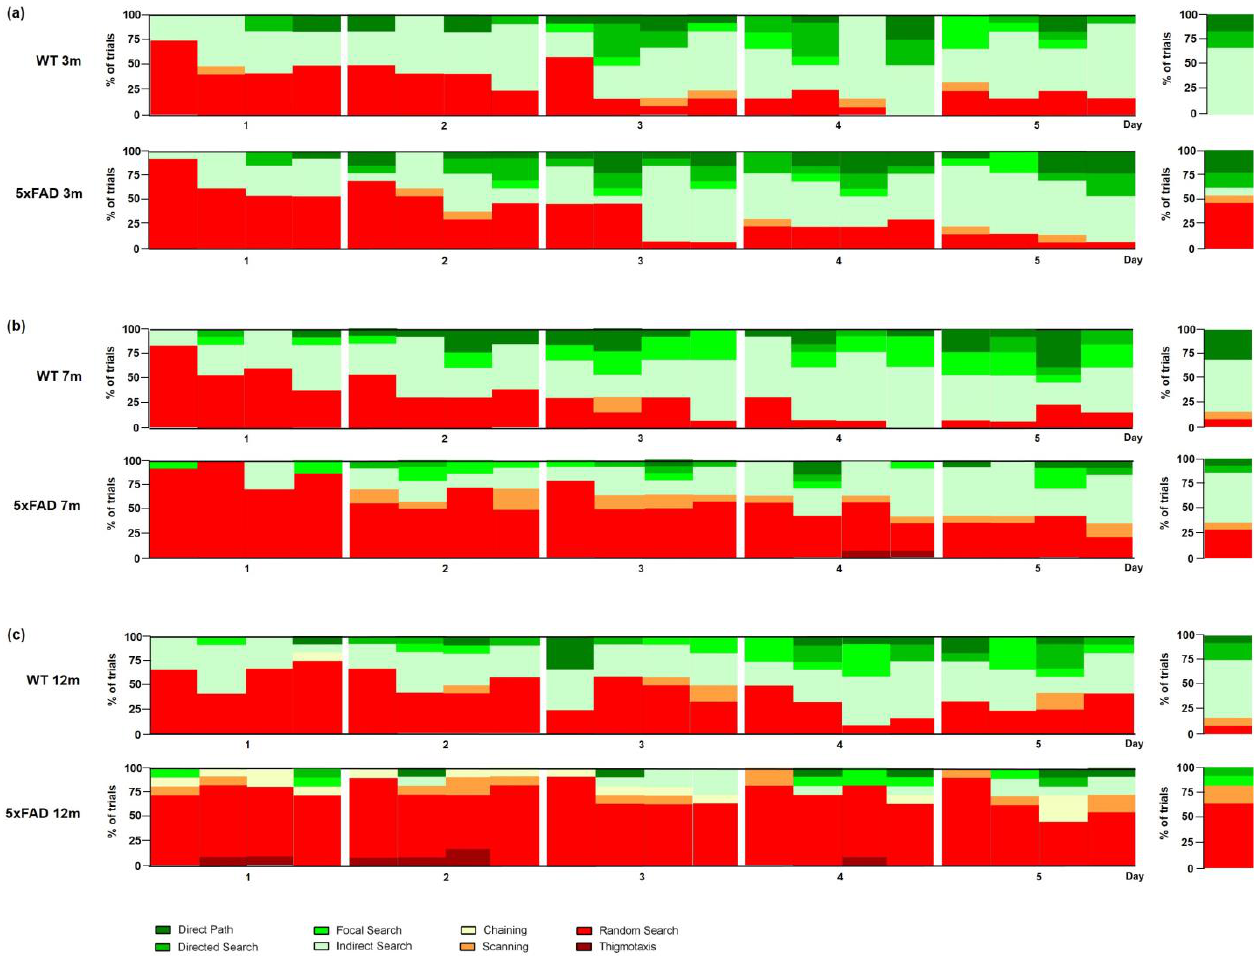
Figure 6. Qualitative analysis of spatial learning in female 5xFAD mice. Search strategies used by female 3 m- ( a ), 7 m- ( b ), and 12 m- ( c ) old 5xFAD and WT mice. Data represent the percentage of search strategies performed in each trial over the five days of acquisition training and during the probe trial. n = 10 – 13.